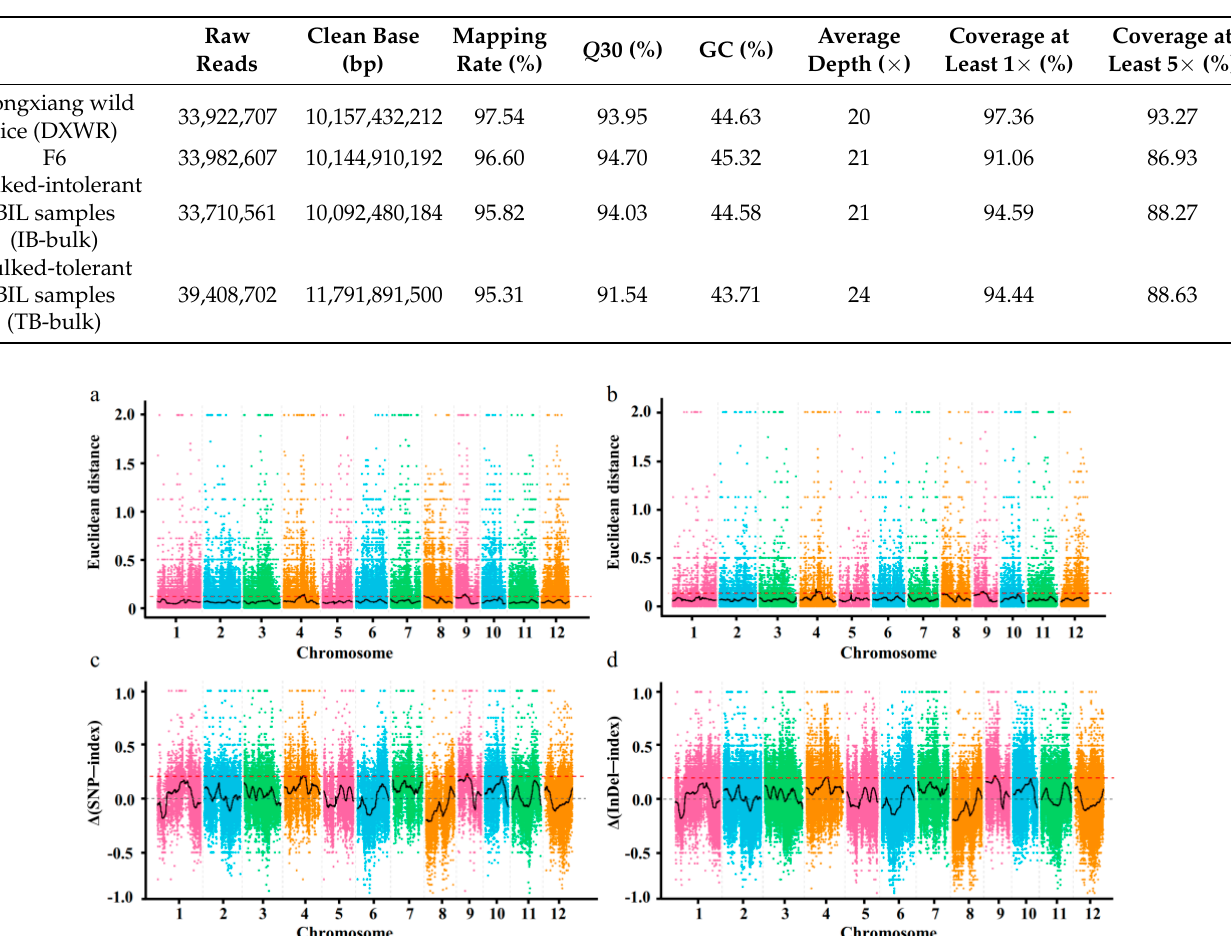
Figure 2. The identifcation of candidate genome regions for seed storability by Euclidean Distance (ED) and delta—index methods. ( a ) SNP—ED association algorithm. ( b ) InDel—ED association algorithm. ( c ) Δ (SNP—index) method. ( d ) Δ (InDel—index) method. The abscissa is the chromosome number, the colored dot represents the calculated ED value or Δ (SNP—index)/ Δ (InDel—index) value of the SNP/InDel site, and the black line is the fitted ED value or Δ (SNP—index)/ Δ (InDel—index) value. The red dashed horizontal lines represent the signifcance association threshold. Table 2. Candidate regions of seed storability of DXWR.